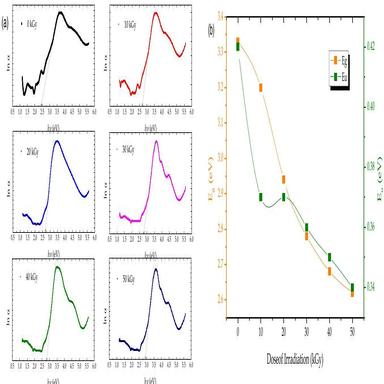
(a) The Urbach energy (Eu) tail and (b) variation of the energy bandgap (Eg) and Urbach energy (Eu) for PVA/PANI/functionalized CNT at 6 pph of functionalized CNT content as a function of different irradiation doses.